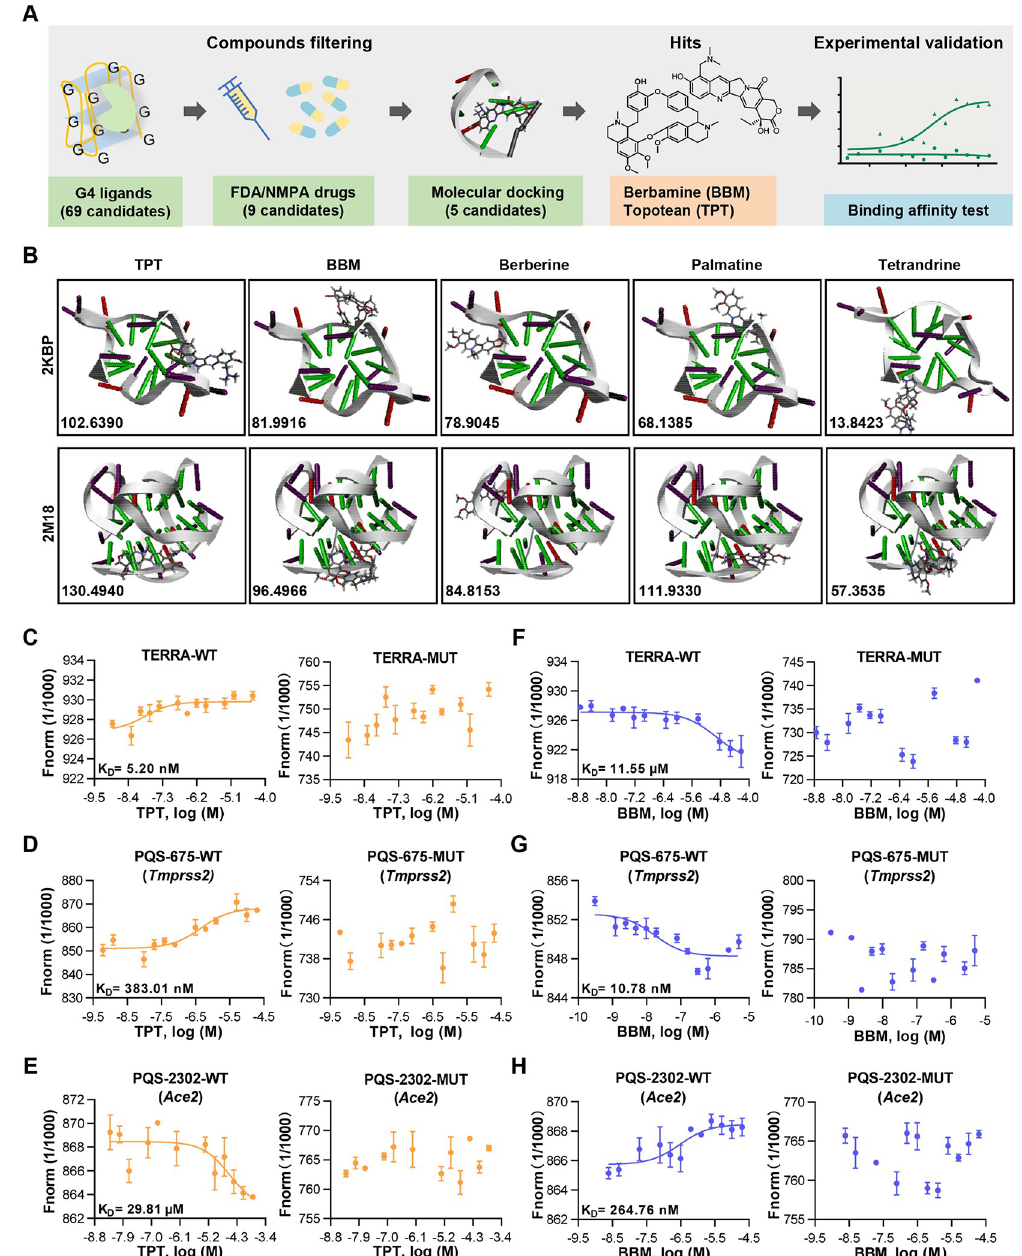
Fig 2. Filtering and verification of RG4-binding repurposed drugs. (A) Flow chart depicting the process of in silico identification and in vitro verification of RG4-based drugs. The number of drug candidates after each filtering step is shown, and TPT and BBM are finally identified. (B) Molecular docking of five drug candidates with TERRA-derived RG4 structures (PDB: 2KBP & 2M18) using Discovery Studio software. (C-H) Binding affinity of TPT (C-E) and BBM (F-H) to the WT (left panel) or mutant (right panel) RG4 RNA of TERRA (C, F), PQS-675 of Tmprss2 (D, G), and PQS-2302 of Ace2 (E, H) by microscale thermophoresis (MST) analysis. The dose − response curve for interactions was fitted with the dissociation constant (KD) model. Data are shown as mean ± SEM, n = 3. Fig 2A was created using Microsoft PowerPoint and Adobe Illustrator.